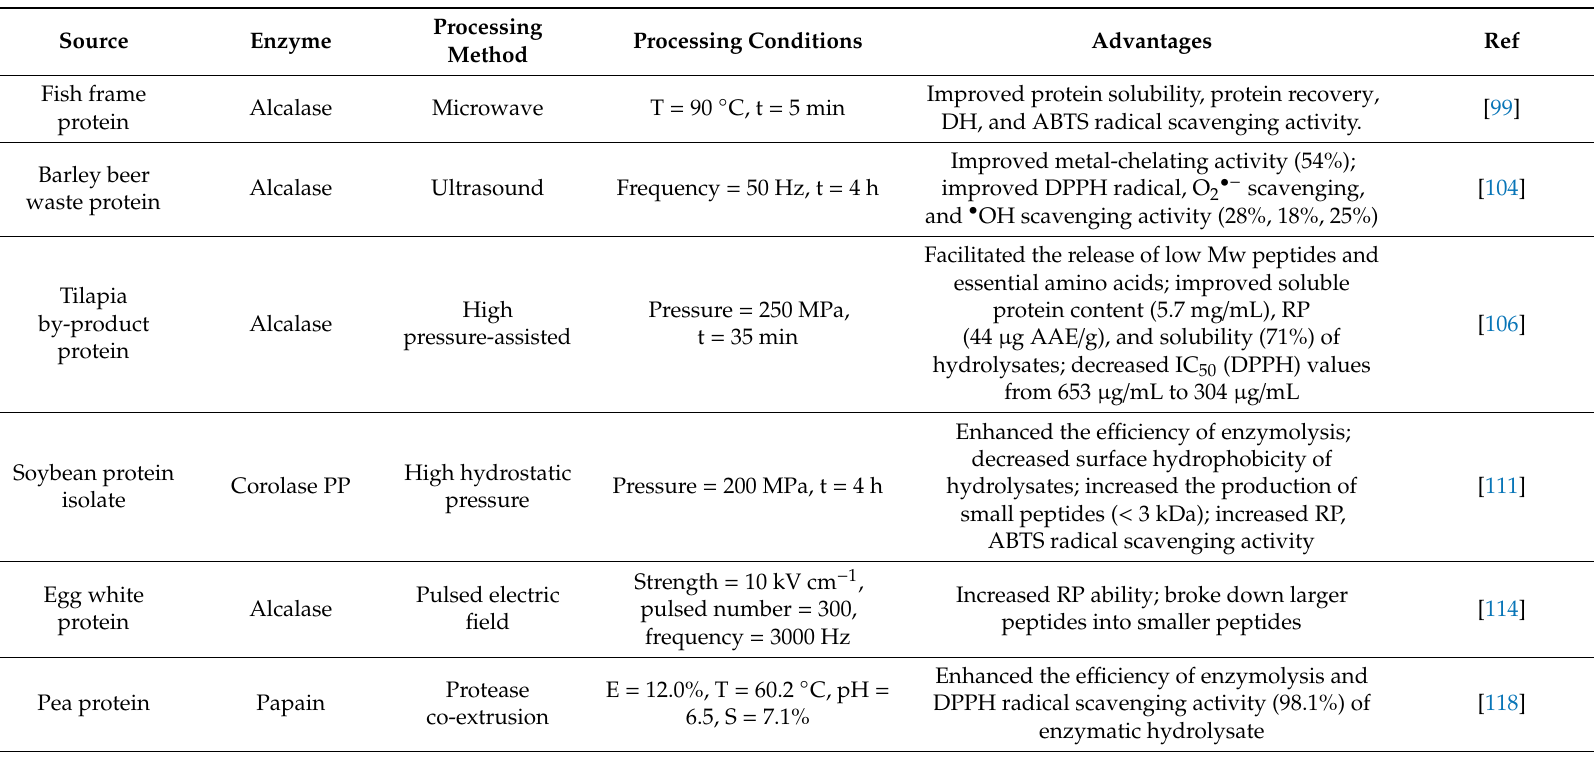
Table 2. The e ff ect of di ff erent pretreatment or co-treatment methods on the preparation of peptidic antioxidants by enzymatic hydrolysis 1